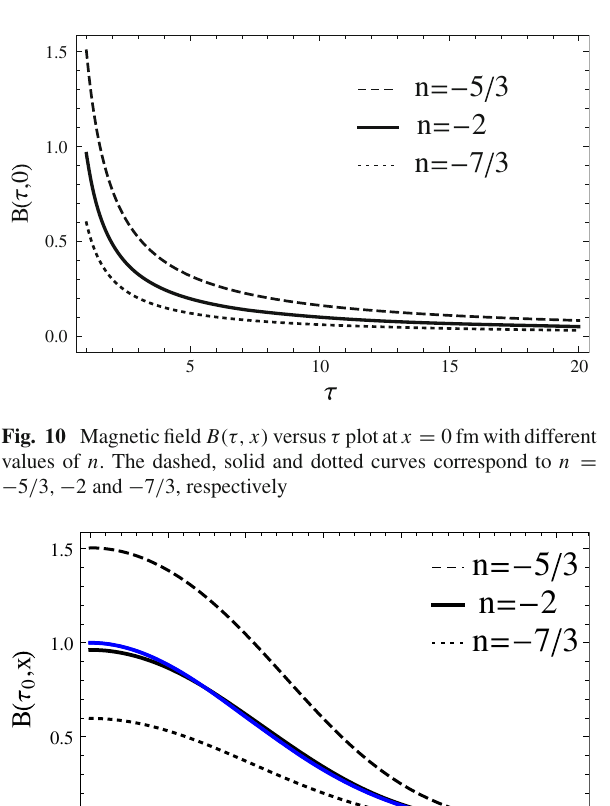
Fig. 9 Magnetic field B (τ, x ) versus x plot at τ = 1 with different values of n . The dashed, solid and dotted curves correspond to n = − 5 / 3 , − 2 and − 7 / 3, respectively